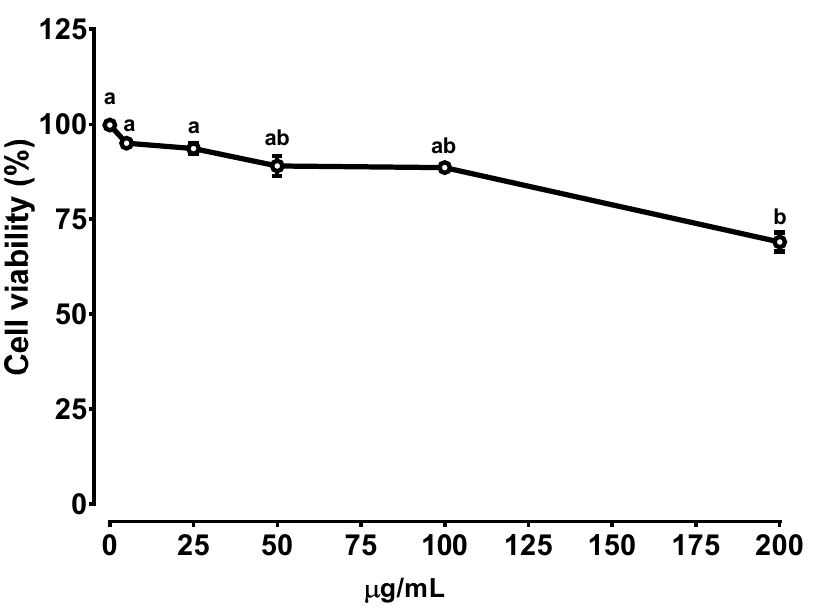
Figure 1. The cytotoxicity measurement of BE-treated Caco-2 cells. The cells were treated with increasing concentration (0–200 μ g/mL) of BE for 24 h. Data points with different letters are significantly different ( p < 0.05). Data are shown as means ± S.E.M. n = 6.